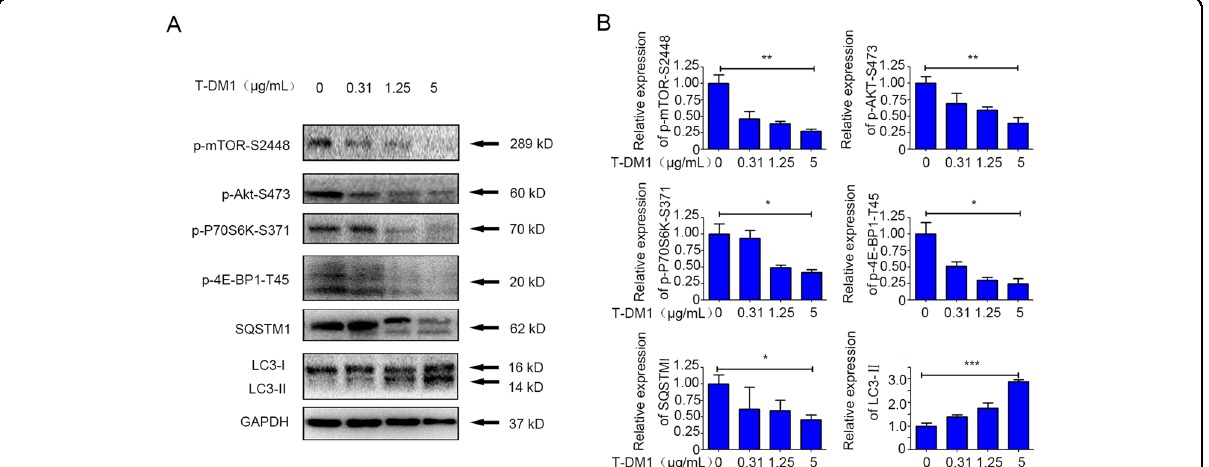
Fig. 7 The Akt/mTOR signaling pathway was inactivated by T-DM1 treatment. A NCI-N87 cells were cocultured with T-DM1 for 48 h, and immunoblot analysis was applied to examine SQSTM1, LC3, p-Akt, p-mTOR, p-P70S6K, and p-4E-BP1 expression in cell lysates. B ImageJ software was used to evaluate the densitometric values of NCI-N87 cells samples and normalize the densitometric values to the corresponding control value. The data of the control were set as 1.0. The results are shown as the mean ± S.D. of 3 independent experiments. Student ’ s t -test. * P < 0.05, ** P < 0.01, and *** P <